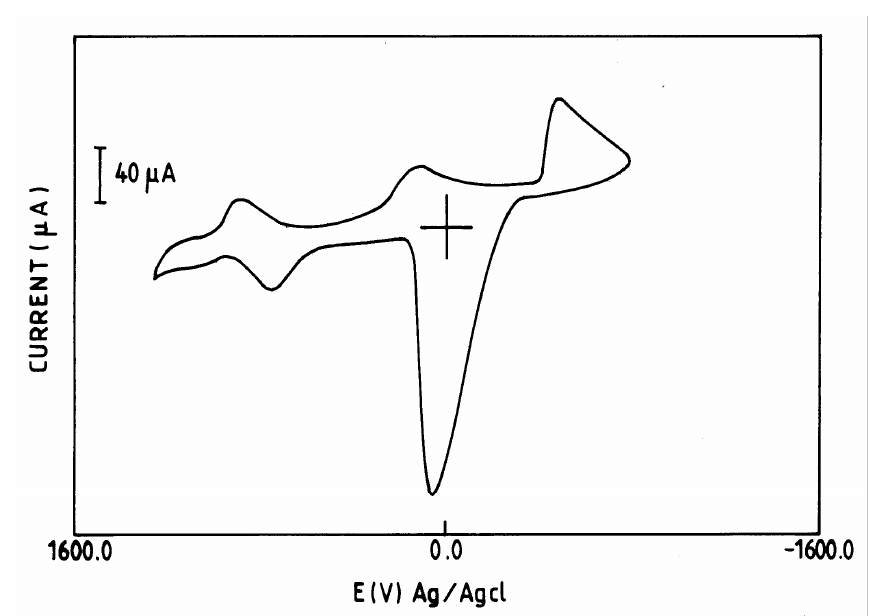
Fig. 3 Cyclic voltammogram of copper